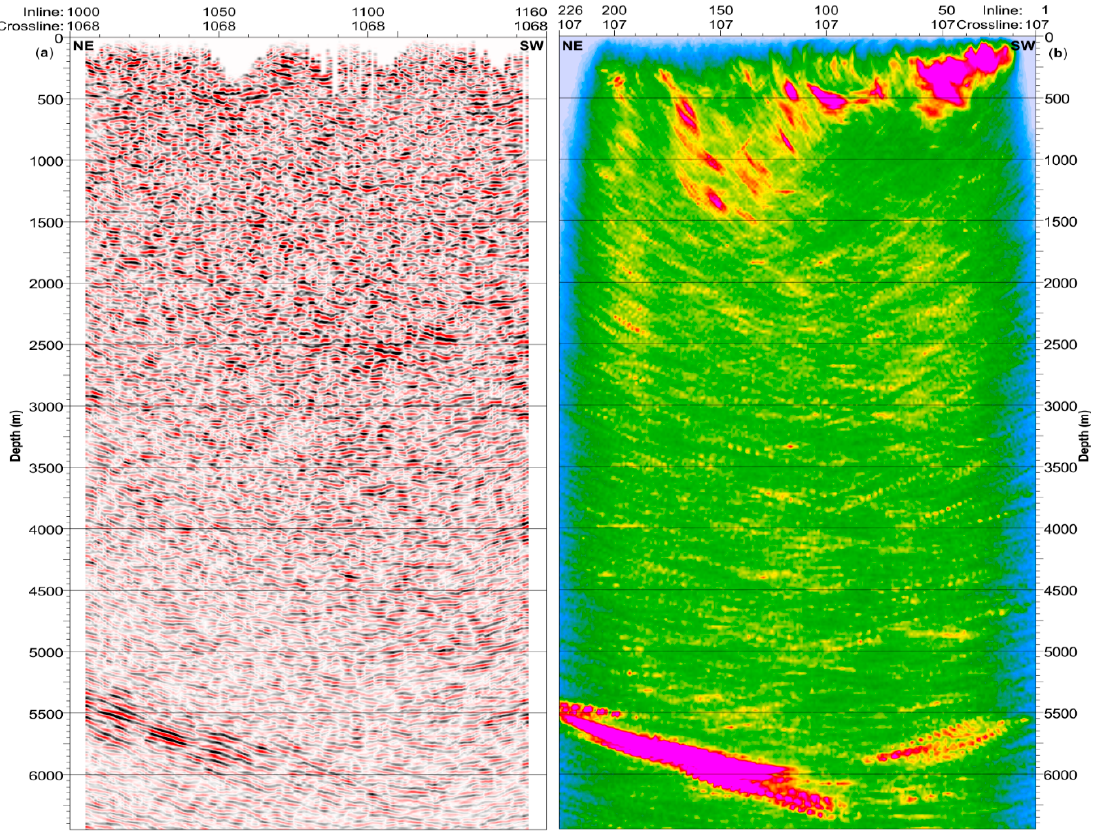
Figure 9. Comparison of the time vs. depth imaging results along a crossline through the ore zone (see Figure 1 for location). ( a ) PoSTM; ( b ) CBFVM for velocity model with refraction statics applied (same